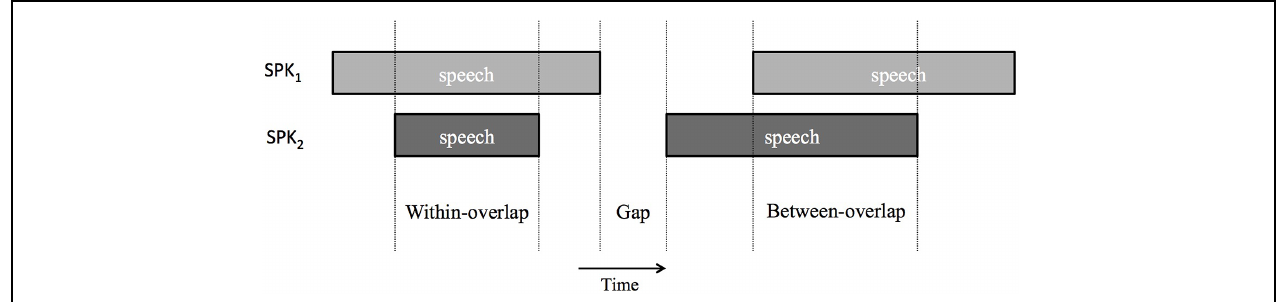
FIGURE 1 | Illustration of gaps, within-overlaps, and between-overlaps for two speakers (SPK 1 and SPK 2 ) in our classification scheme following Heldner and Edlund (2010).